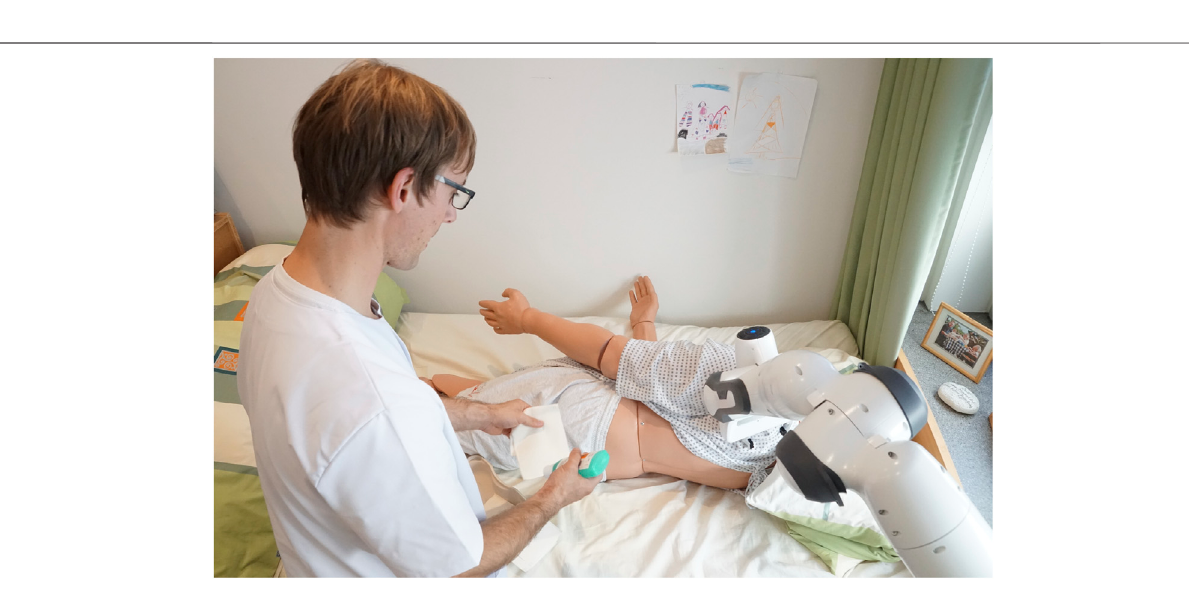
Frontiers in Robotics and AI |